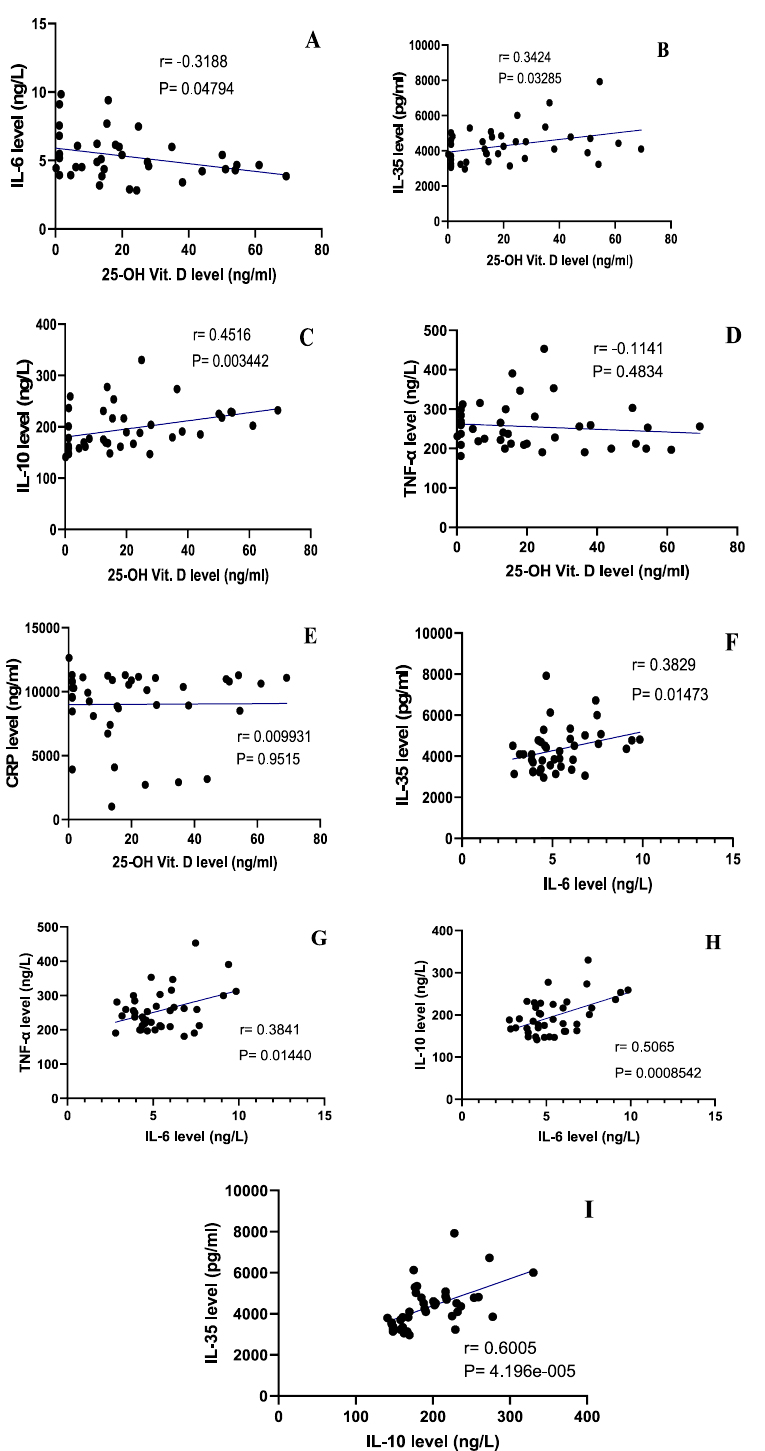
Fig. 2. Correlation amid 25-OH Vit. D and IL-6 (A), 25-OH Vit. D and IL-35 (B), 25-OH Vit. D and IL-10 (C), 25-OH Vit. D and TNF-α (D), 25-OH Vit. D and CRP (E), IL-6 and IL-35 (F), IL-6 and TNF-α (G), IL-6 and IL-10 (H), finally IL-10 and